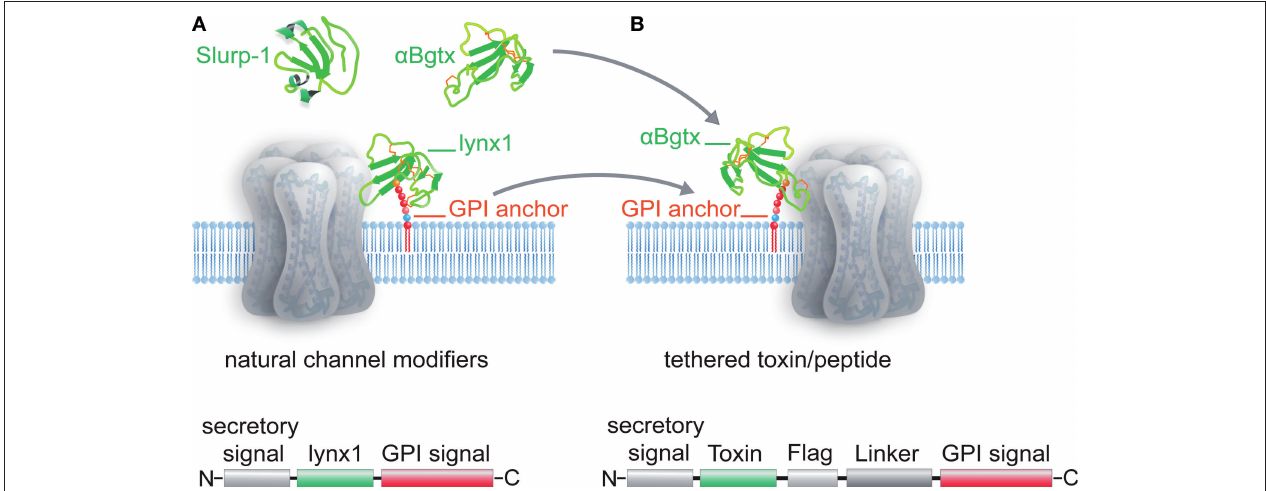
FIGURE 1 | Schematic representation of Ly-6/uPAR channel modifi ers and engineered tethered toxins (t-toxins). (A) Examples of the Ly-6/uPAR superfamily include soluble Slurp-1, snake α -bungarotoxin ( α Bgtx) and the GPI- anchored cell-membrane bound lynx1. The schematic below the drawing of the channel indicates the coding sequences associated with lynx1, namely an N- terminal secretory signal region, followed by the amino acid residues that correspond to the lynx1 peptide, and a C-terminal GPI anchor. (B) The structural